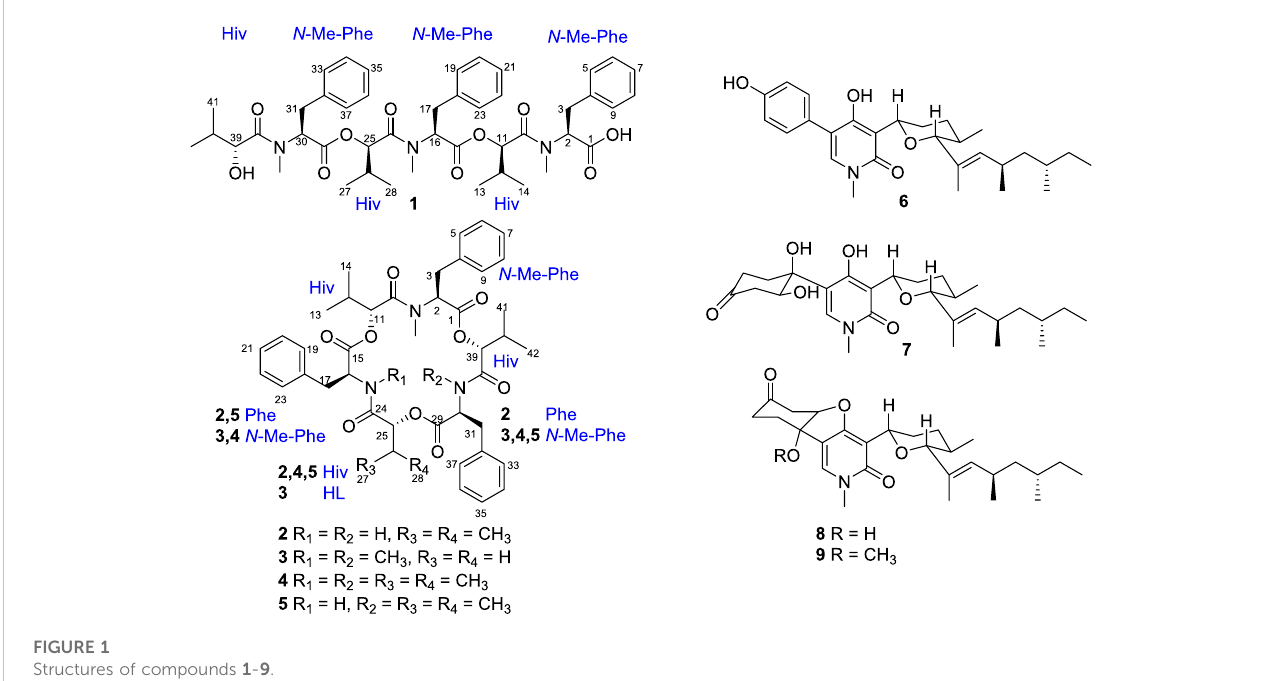
FIGURE 1 Structures of compounds 1 - 9